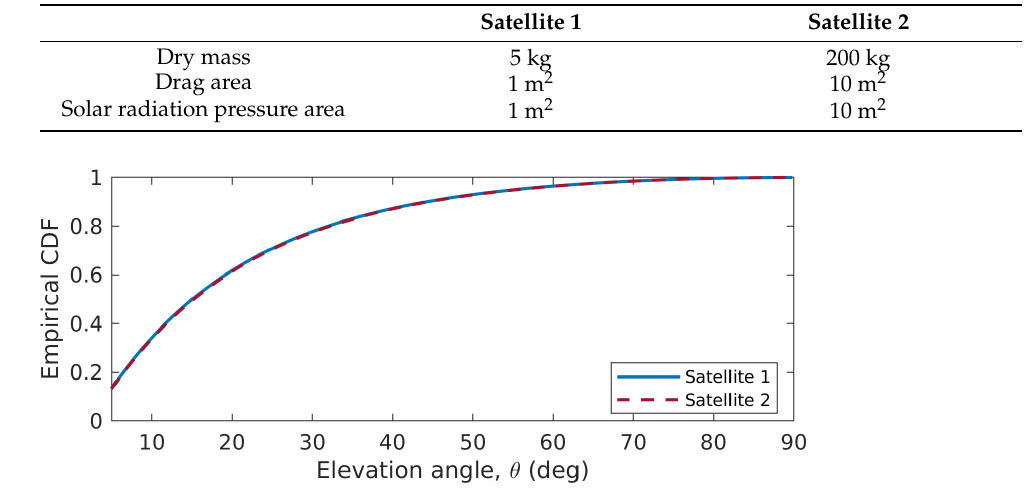
Figure 14. CDF F Θ ( θ ) for different satellite mass and drag area